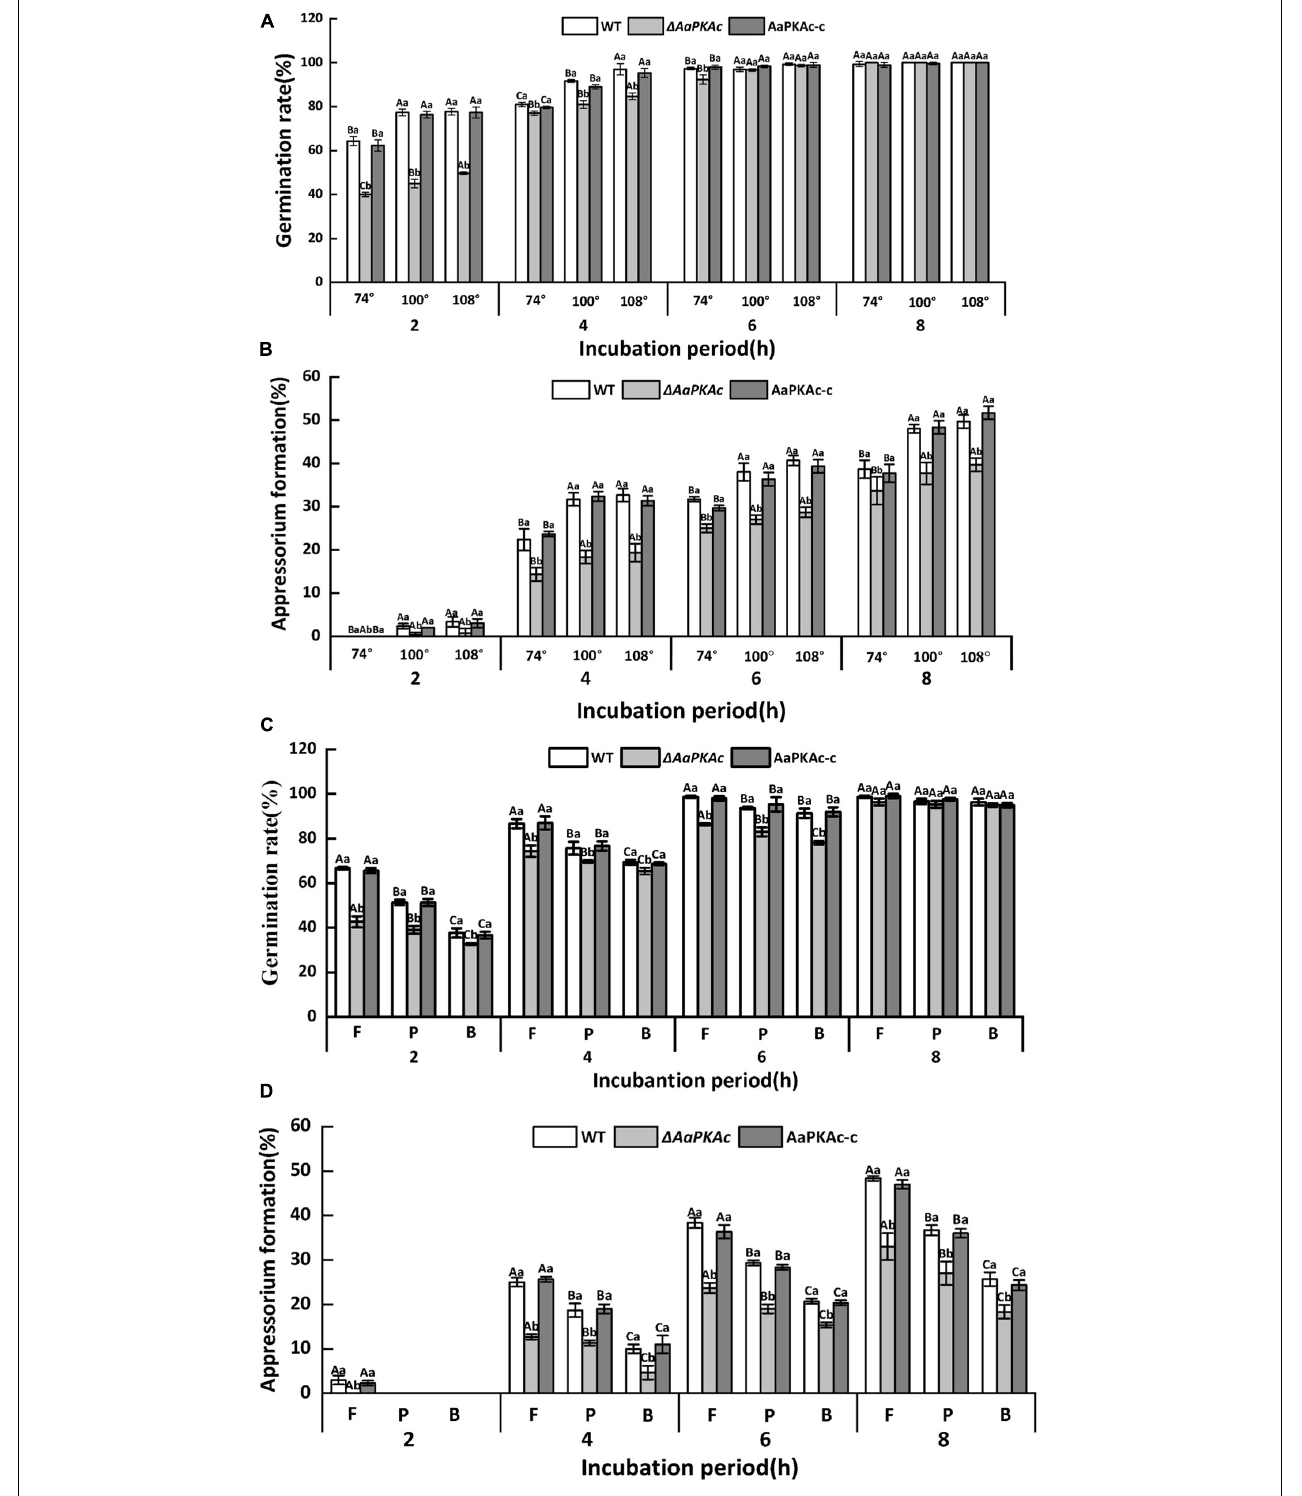
FIGURE 2 | Effect of AaPKAc on spore germination rate (A,C) and appressorium formation rate (B,D) of the wild-type strain (WT), the (cid:49) AaPKAc mutant, and AaPKAc genetic complementation strain (AaPKAc-c) induced by different hydrophobic surfaces (74 ◦ , 100 ◦ , 108 ◦ ) and fruit wax (F), paraffin (P), and beeswax (B) coating surface. The vertical line indicates a standard error ( ± SE). Uppercase letters indicate differences among different contact angles; lowercase letters indicate the same difference in contact angle among treatments ( P < 0.05).